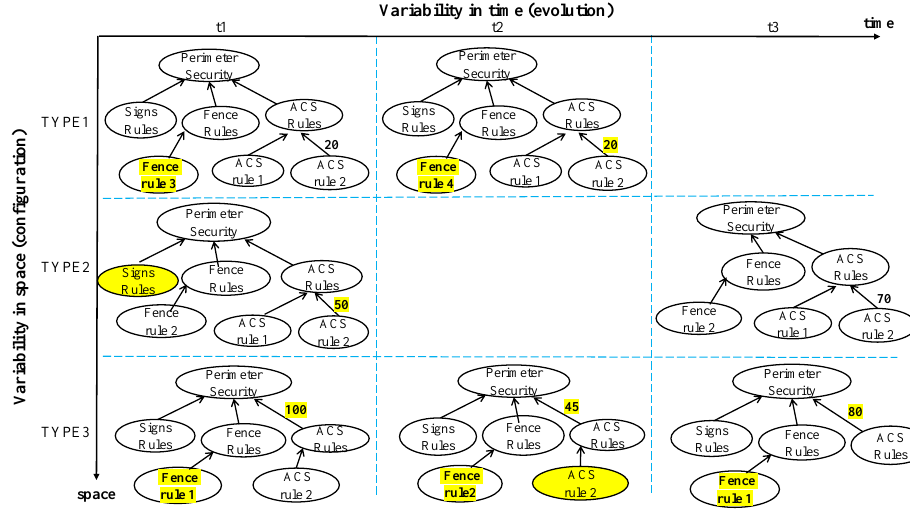
Figure 2. Goal model family of regulations with variability in space and